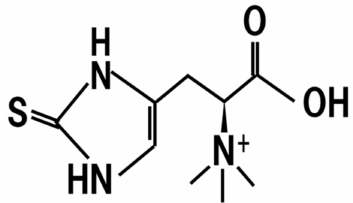
Figure 7. Chemical structure of ergothioneine.